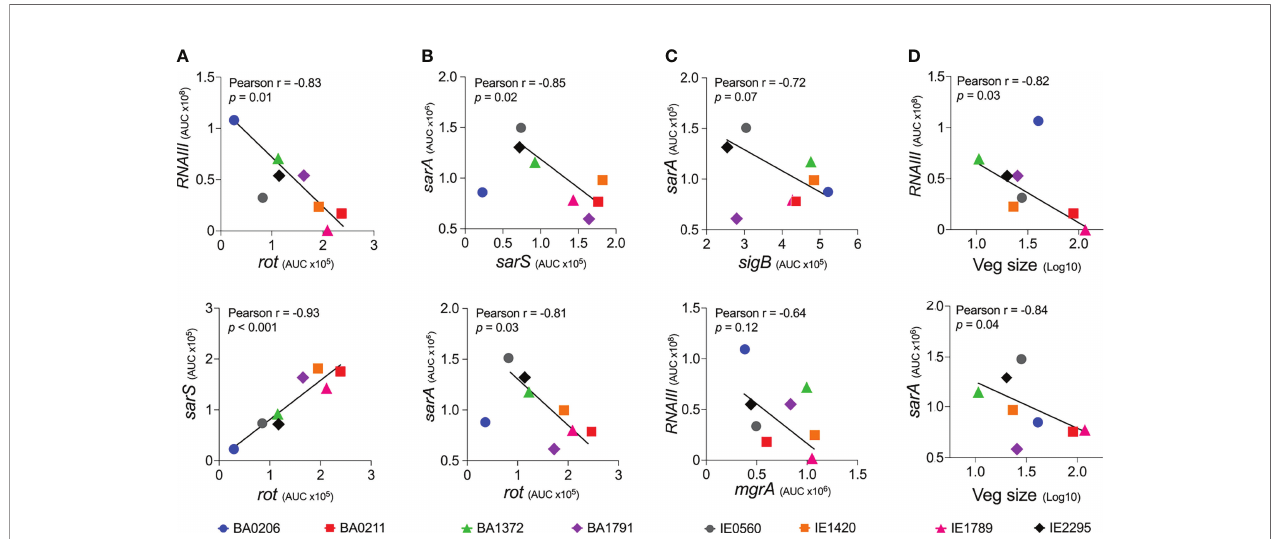
FIGURE 8 | Vegetation formation inversely correlates with RNAIII and sarA expression in S. aureus CC5 isolates. (A) Expression correlation between RNAIII and rot (top panel) or rot and sarS (bottom panel). (B) Expression correlation between sarA and sarS (top panel) or sarA and rot (bottom panel). (C) Expression correlation between sigB and sarA (top panel) or RNAIII and mgrA (bottom panel). (D) Correlation between vegetation size and RNAIII expression (top panel) or sarA expression (bottom panel). Pearson correlation coef fi cients (Pearson r), correlation p value, and best- fi t line shown. Expression correlation between RNAIII and sigB is not shown; Pearson r = -0.34 ( p =